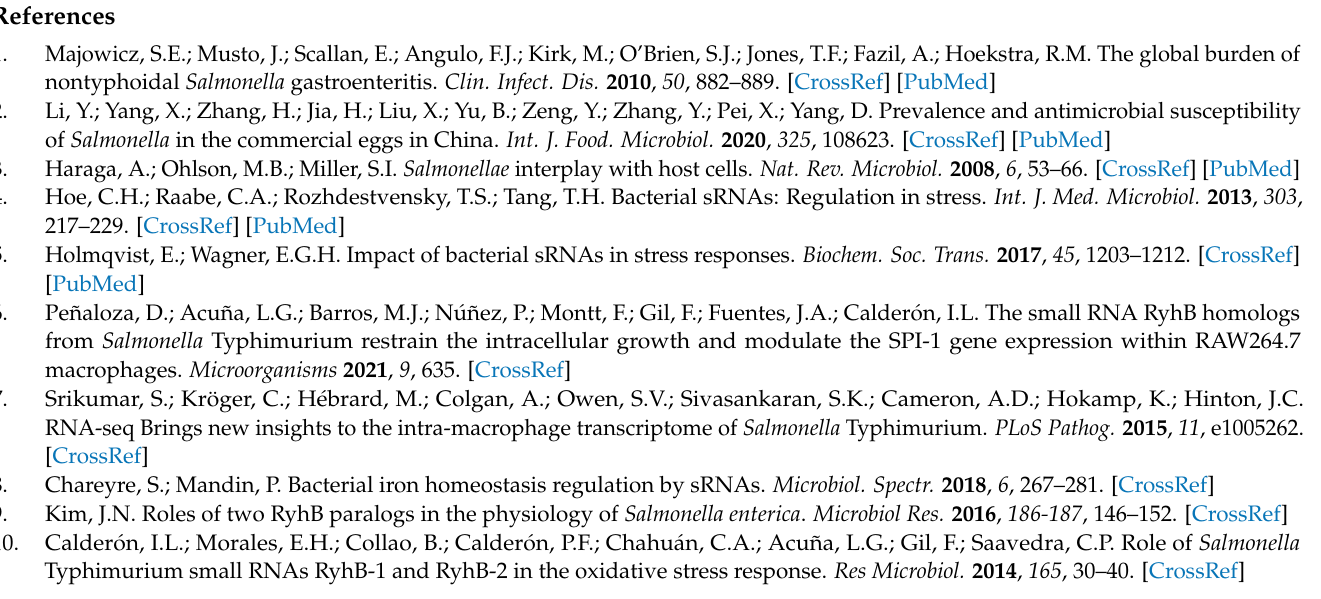
qRT-PCR. Table S2. Primers for construction of recombinant plasmids. Table S3. Summary about total reads successfully aligned to reference genome. Table S4. Information of 13 candidate target genes screened byRNA-Seq. Figure S1: Interaction site prediction between RyhB-1/RyhB-2 and putative target